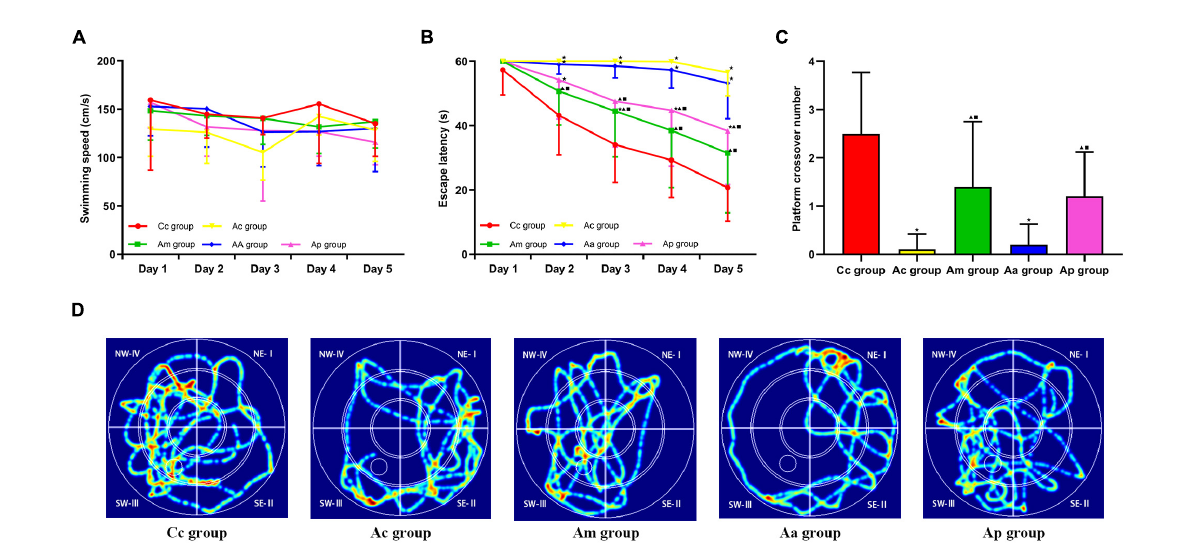
FIGURE1 Results of the Morris water maze (MWM) tests in each group ( n = 10, mean ± SD). (A,B) Comparison between the swimming speed and escape latency of all groups in the hidden platform trial. (C) Comparison between the platform crossover numbers of all groups in the probe trial. A two-way analysis of variance (ANOVA) with repeated measures, followed by the LSD multiple-range test, was used with an exception when comparing the platform crossover numbers, which was analyzed by using the Kruskal–Wallis test. LSD-t and chi-square are presented in Supplementary Tables 1, 2 . (cid:70) P < 0.01 or P < 0.05 compared with the C57BL/6 control (Cc) group, (cid:78) P < 0.01 or P < 0.05 compared with the APP/PS1 control (Ac) group, (cid:4) P < 0.01 or P < 0.05 compared with the APP/PS1 antibiotic + manual acupuncture (Aa) group. (D) Swimming trace of all